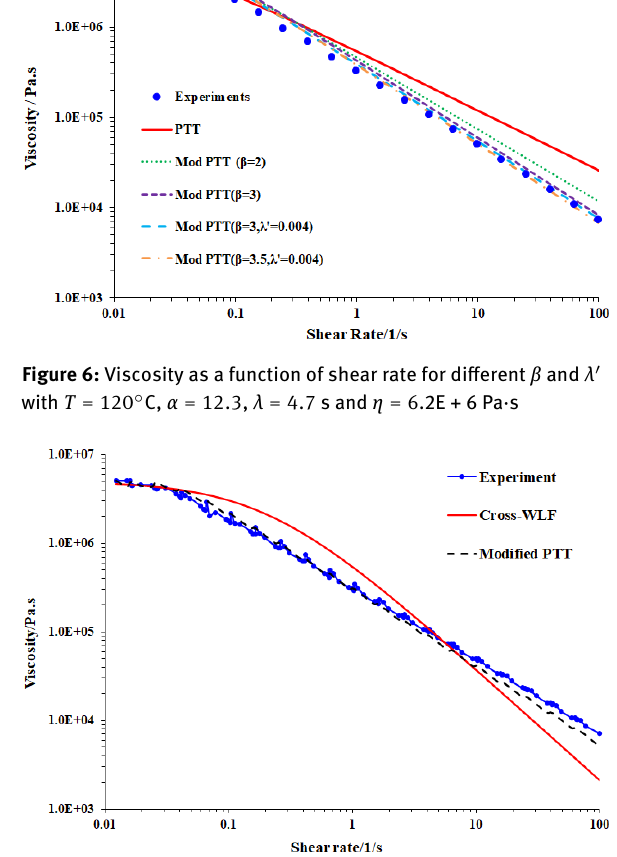
Figure 7: Model precision comparison between Cross and modified PTT at the measured